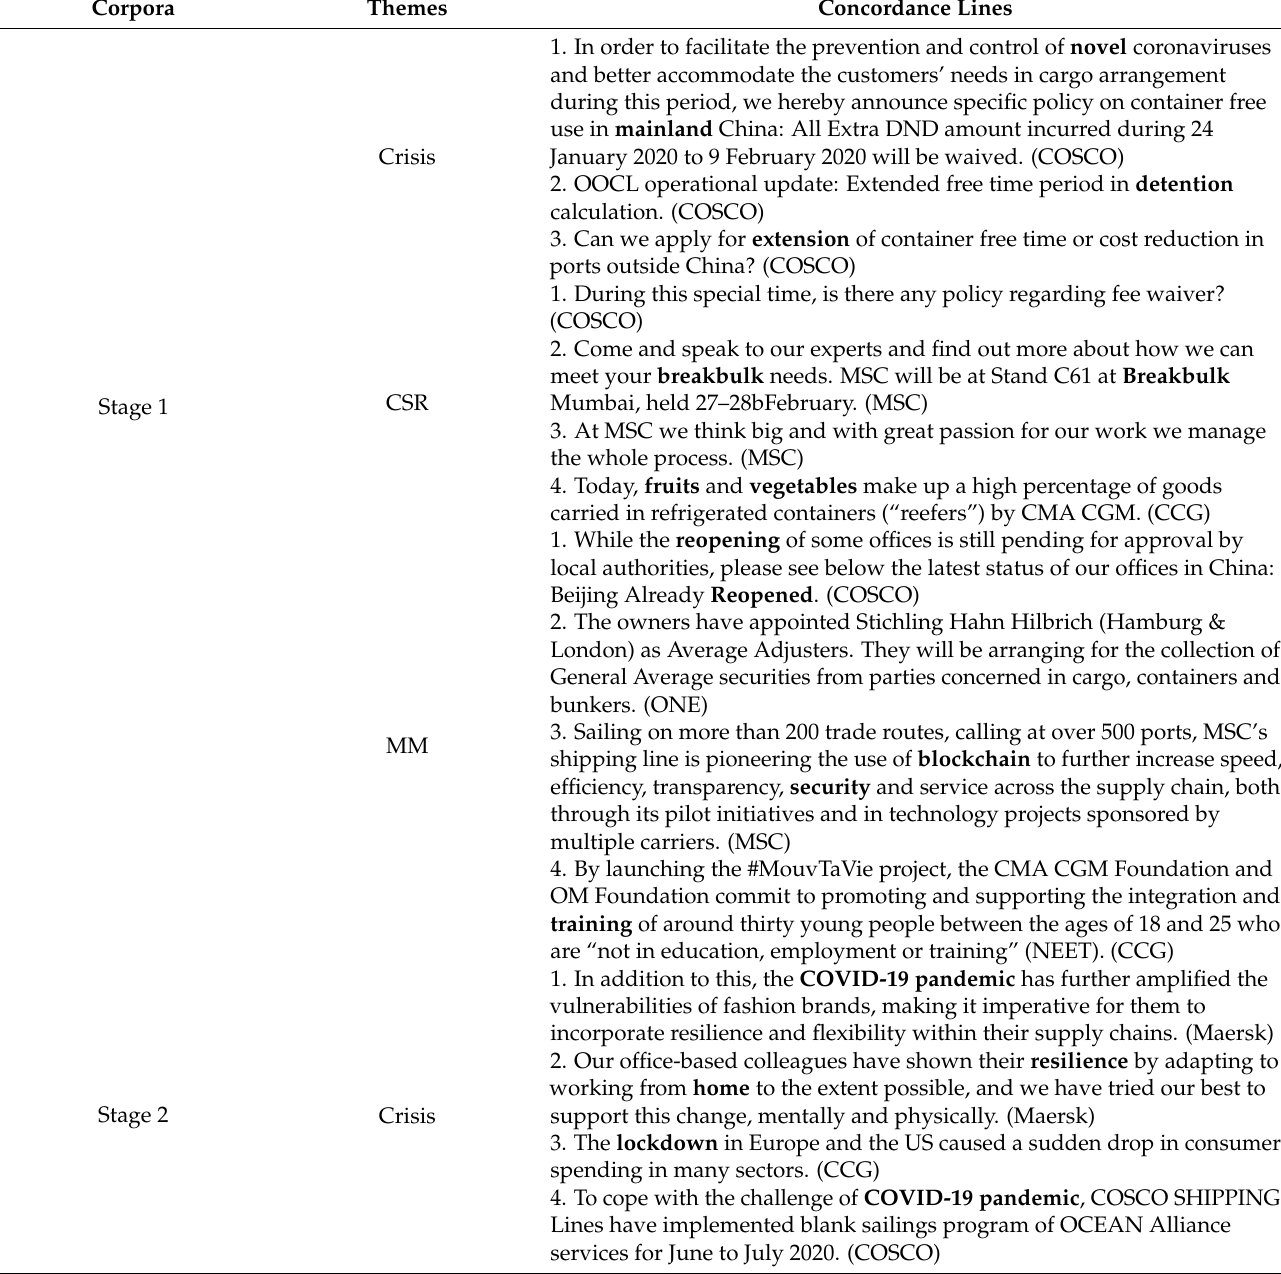
Table A1. Keyword-in-context: exemplary statements for the